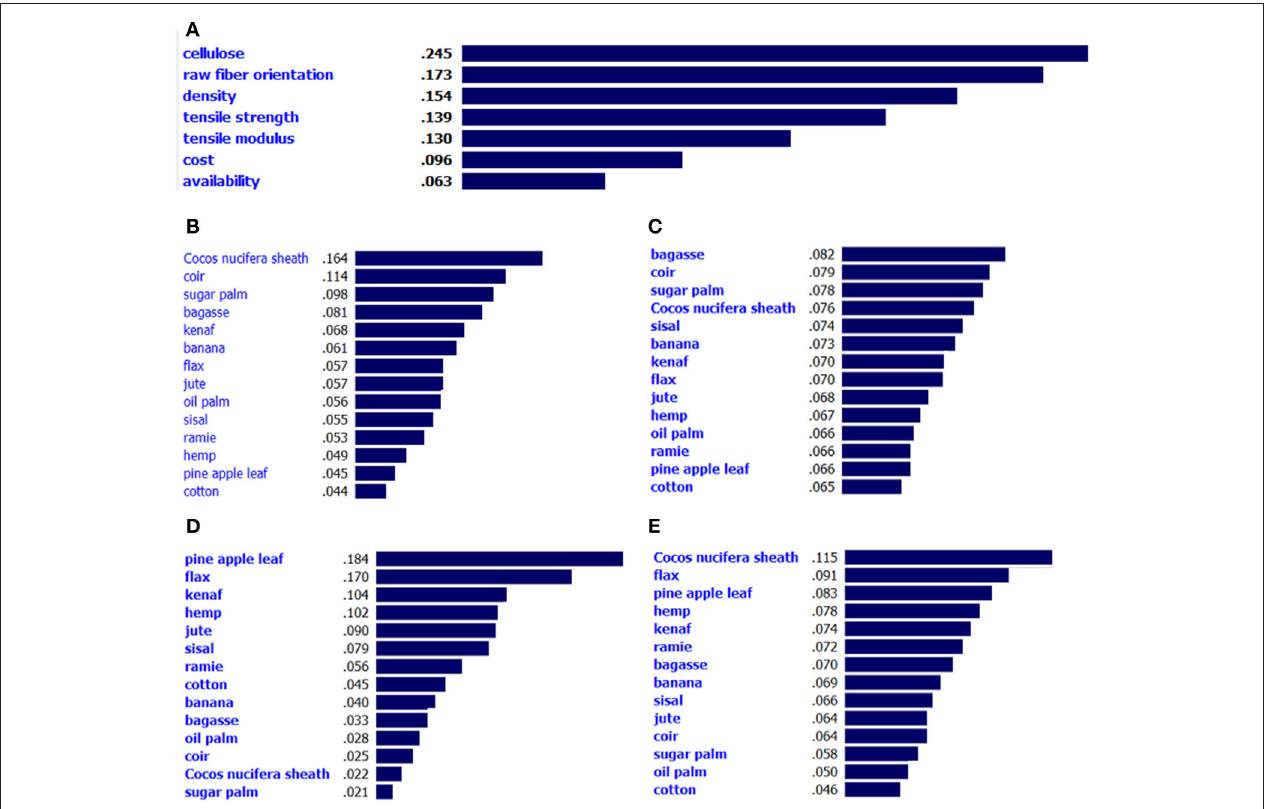
FIGURE 7 | (A) Synthesis with respect to the criteria. (B) Synthesis of alternatives with respect to the cellulose. (C) Synthesis of alternatives with respect to the density. (D) Synthesis of alternatives with respect to the tensile strength. (E) Overall synthesis with respect to the selection of natural fiber.